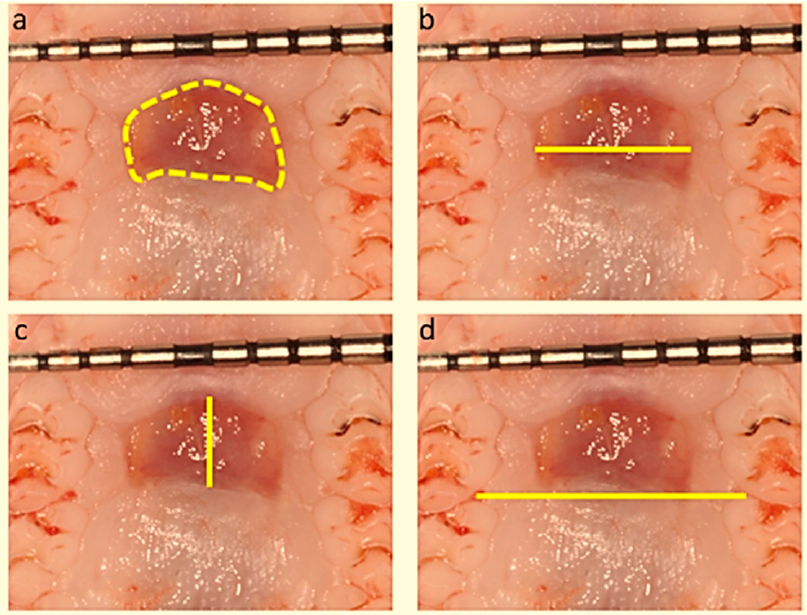
Figure 1. Representative photographs, using 1 mm periodontal probe as scale measurement, of the wound 14 days (W2) after surgery. The wound margins were marked ( a ) and the following measurements were taken: the final wound area ( a ), the final L-L distance ( b ), the final A-P distance ( c ) and the arch distance ( d ).